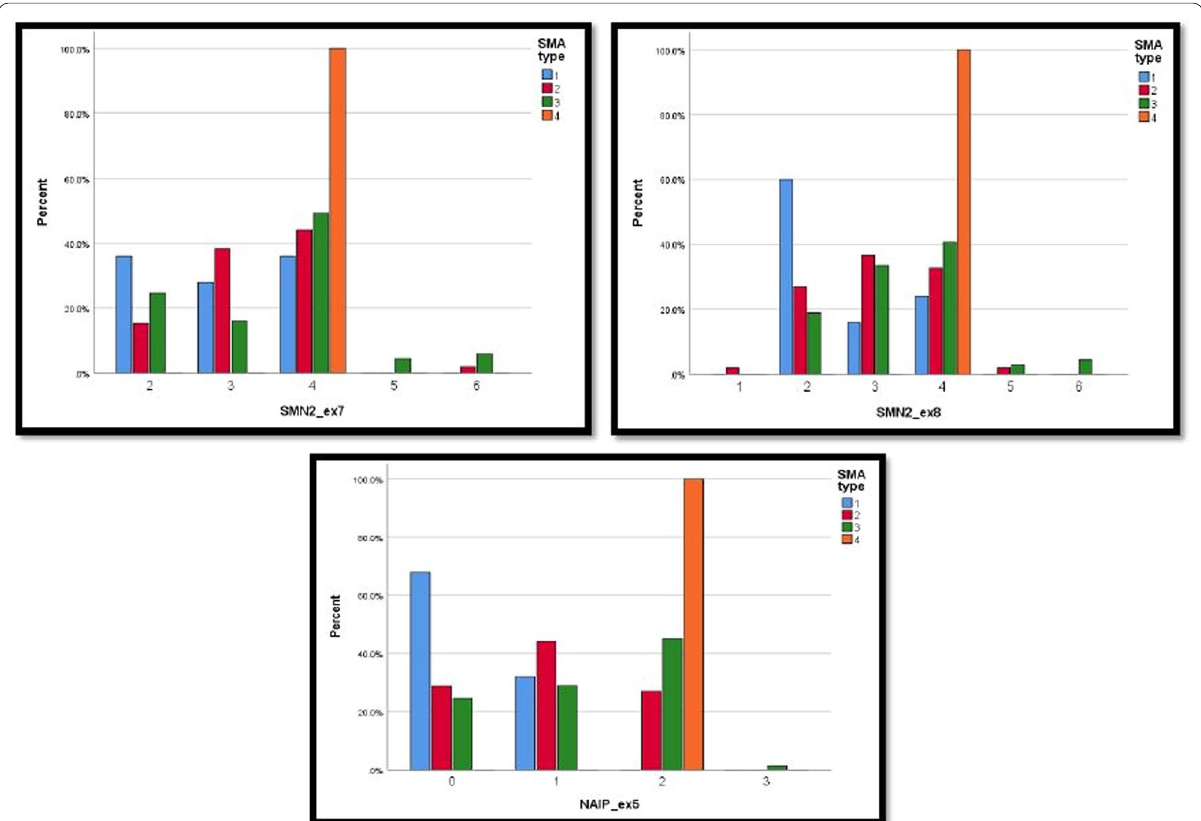
Fig. 1 Bar charts showing Copy number variations of SMN2 and NAIP genes in SMA patients (n SMN1